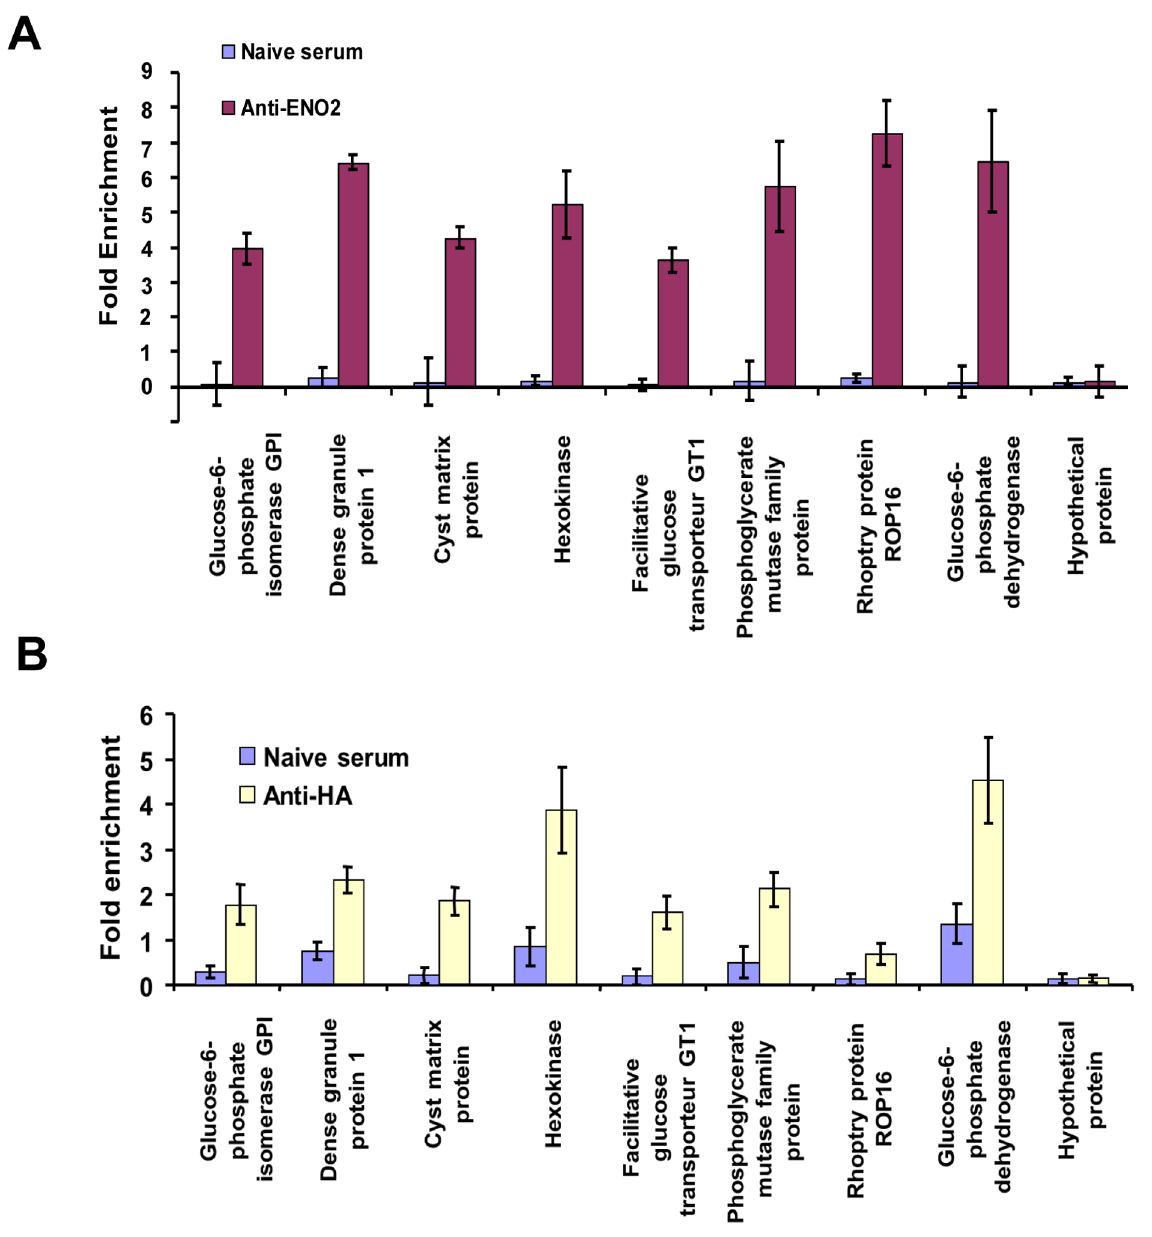
Figure 3. Validation of native TgENO2 and transgenic TgENO2-HA protein bound to several putative gene promoters. A) Quantitative real-time PCR analysis of chromatin immunoprecipitates from three independent experiments (n=3, P , 0.0001) demonstrates specific binding of nuclear TgENO2 in vivo to eight selected genes identified by ChIP-Seq (see Table S4). A gene encoding a hypothetical protein that was absent from the gene hits (TgME49_ 0022080) was used as a negative control. B) Quantitative real-time PCR analysis of chromatin immunoprecipitates from three independent experiments (n=3, P , 0.0001) demonstrates specific binding of nuclear transgenic TgENO2-HA in vivo to eight selected genes identified by ChIP-Seq (see Table S4). The TgME49_ 0022080 gene was used as a negative control. integration of the HXGPRT selectable marker in the entire ENO1 phenolic acid (MPA). MPA-resistant clones were isolated and the knockout (Fig. S4B). For further phenotypic studies, we selected genotype of the clones was evaluated by PCR (Fig. S4A and S4B). one of these positive T. gondii clones and confirmed specific In PCR1, the EXR primer was paired with the CXF primer deletion of the entire open reading frame of TgENO1 gene (Fig. (Table S2) to verify the presence of the 5 9 target flank in all clones S4C, see primers in Table S3). and the parental strain. PCR2 was used to identify clones with a deleted ENO1 gene by the absence of PCR product (clones 1–12, Fig. S4B) compared with the parental strain (lane 13, Fig. S4B). To verify targeted integration of HXGPRT into the deleted ENO1 locus, we used PCR3 and PCR4 to respectively verify 5 9 and 3 9